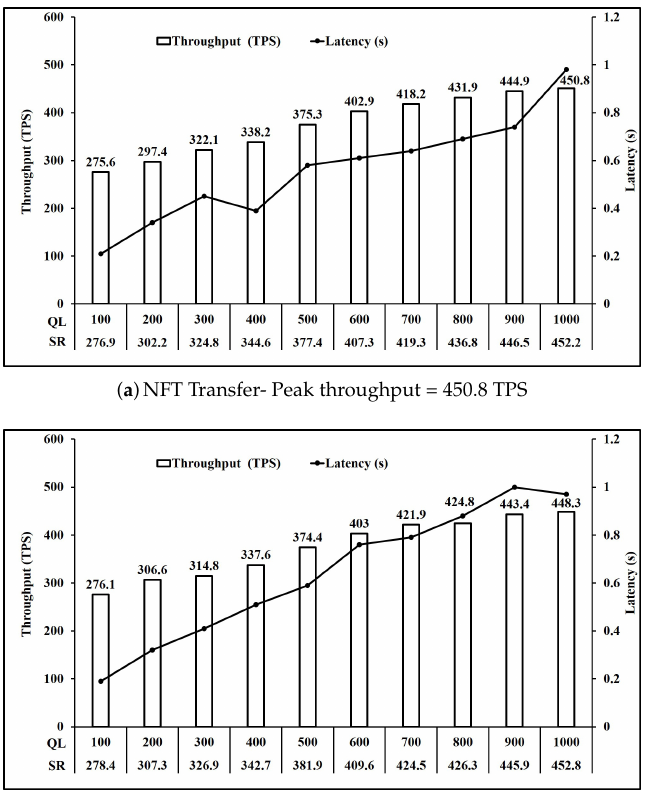
Figure 8. Operations with three write key operations (Queue Length: QL, Send Rate (TPS):